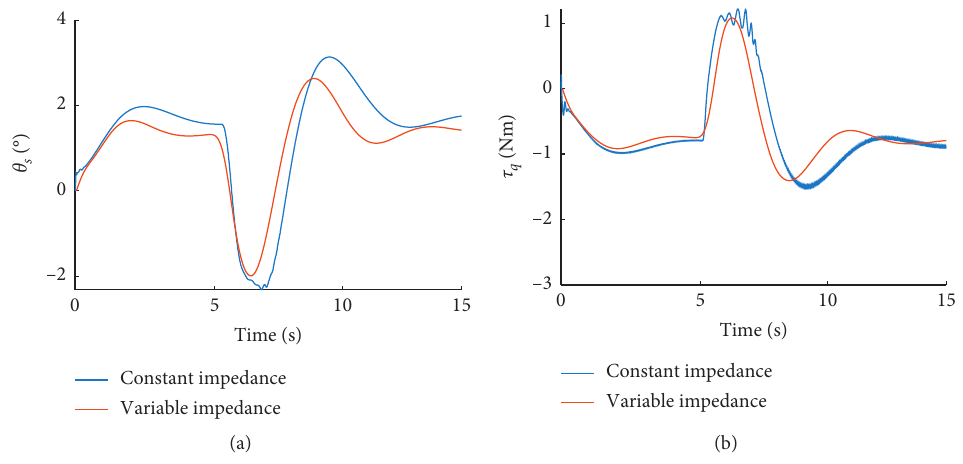
Figure 7: Simulation results of constant impedance and variable impedance control. (a) Tilt angle. (b) Ankle torque.